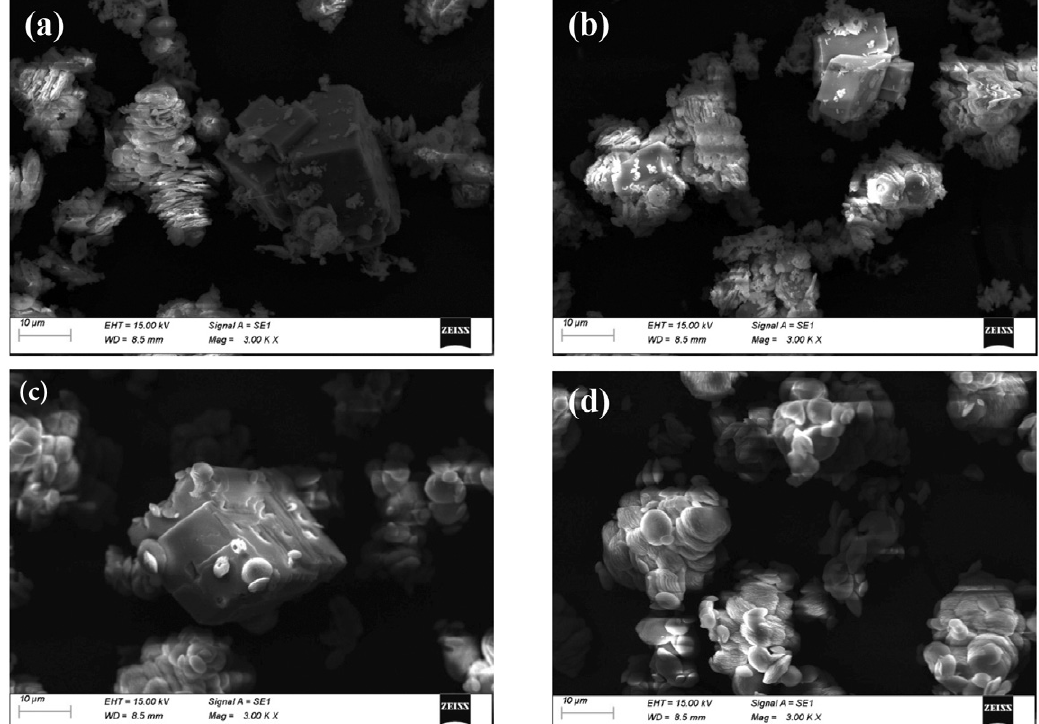
Figure 4. SEM images for CaCO 3 crystals precipitated with 50 ppm tryptophan at t = 30 min (a) and at t = 100 min (b) and with 100 ppm tryptophan at t = 30 min (c) and at t = 100 min